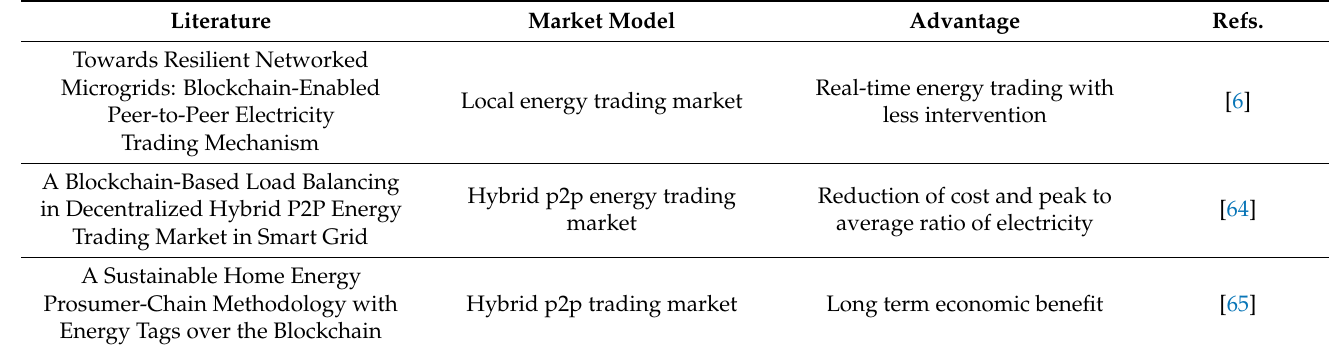
Table 2. The literature depicting the distribution of blockchain-based energy